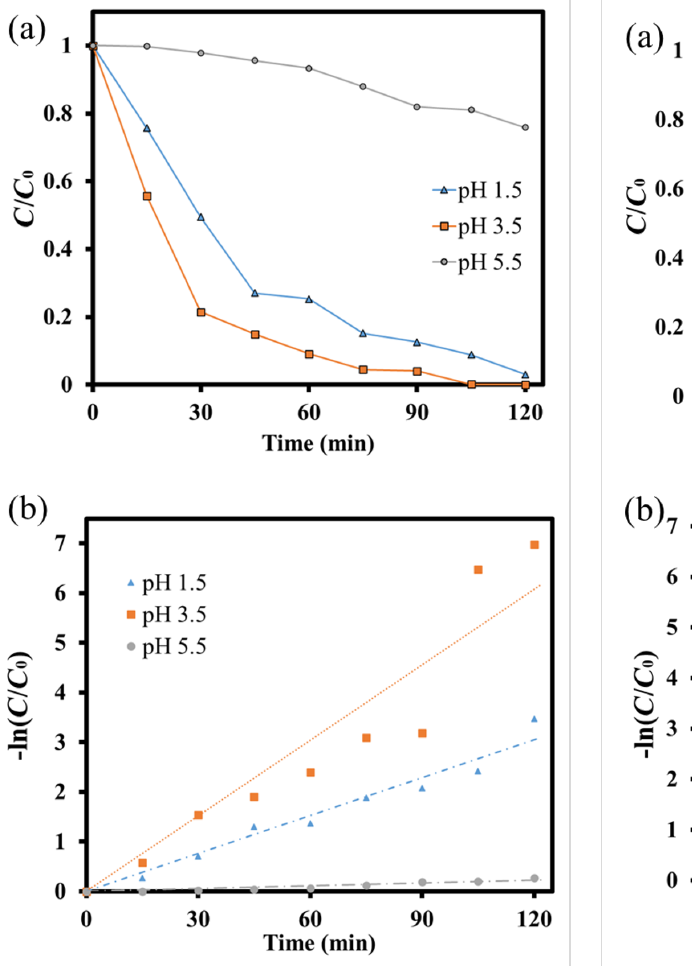
Figure 10: (a) The C / C 0 and (b) 1st order kinetic analysis of the MB photodegradation using LaFe 0.7 Ni 0.3 O 3 operating at different pH values.